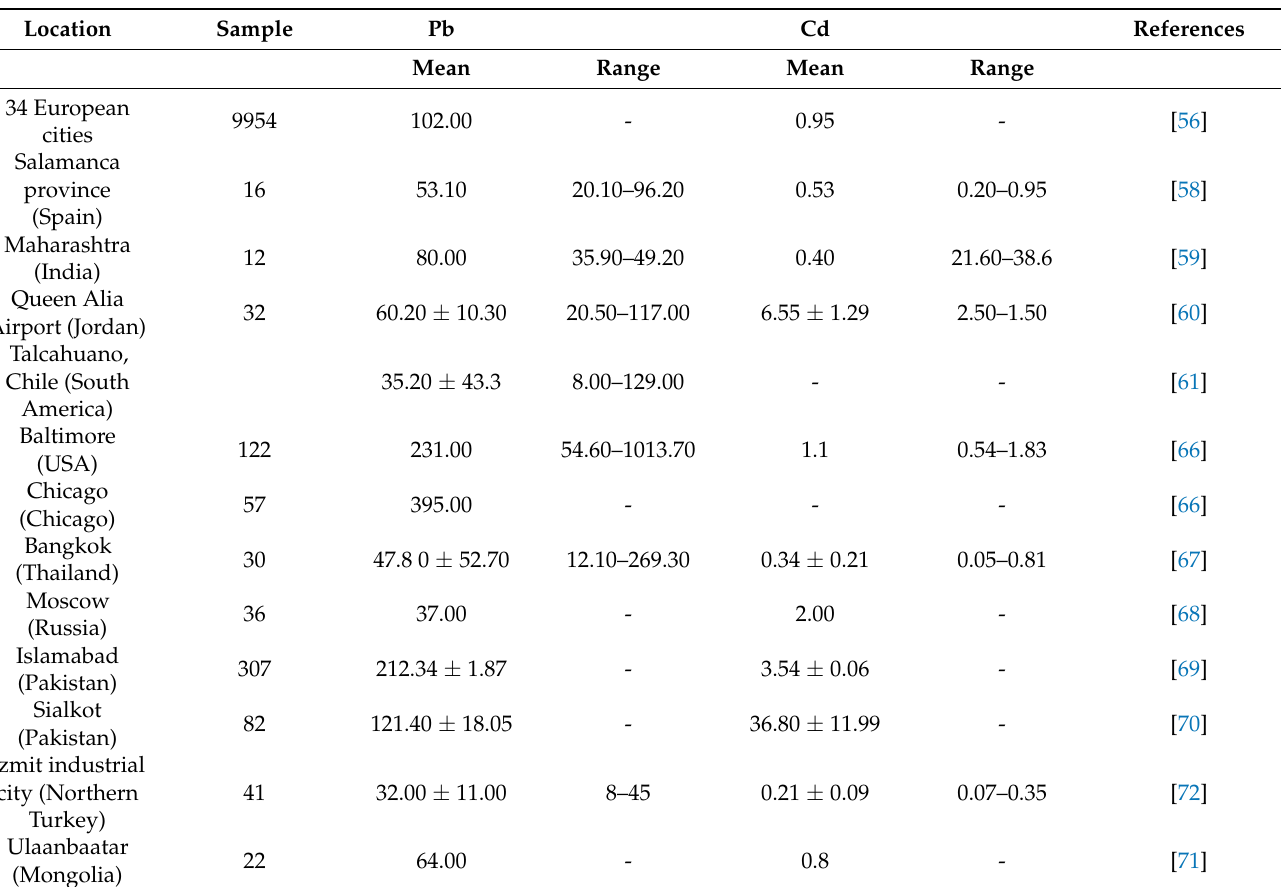
Table 1. Mean concentrations (mg kg − 1 ) of Pb and Cd in urban soils from some cities of the world in comparison to